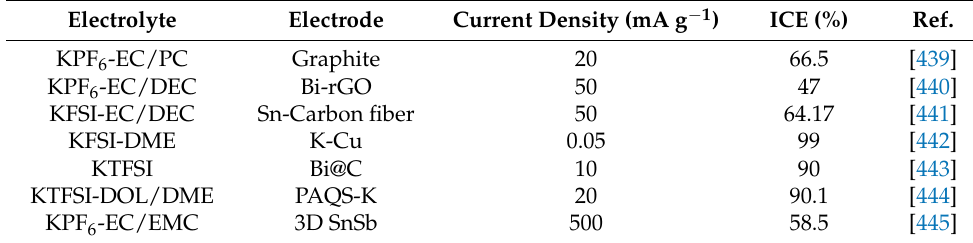
Table 9. Electrolytes used in K-ion batteries and their internal coulombic efficiency (ICE). Electrolyte